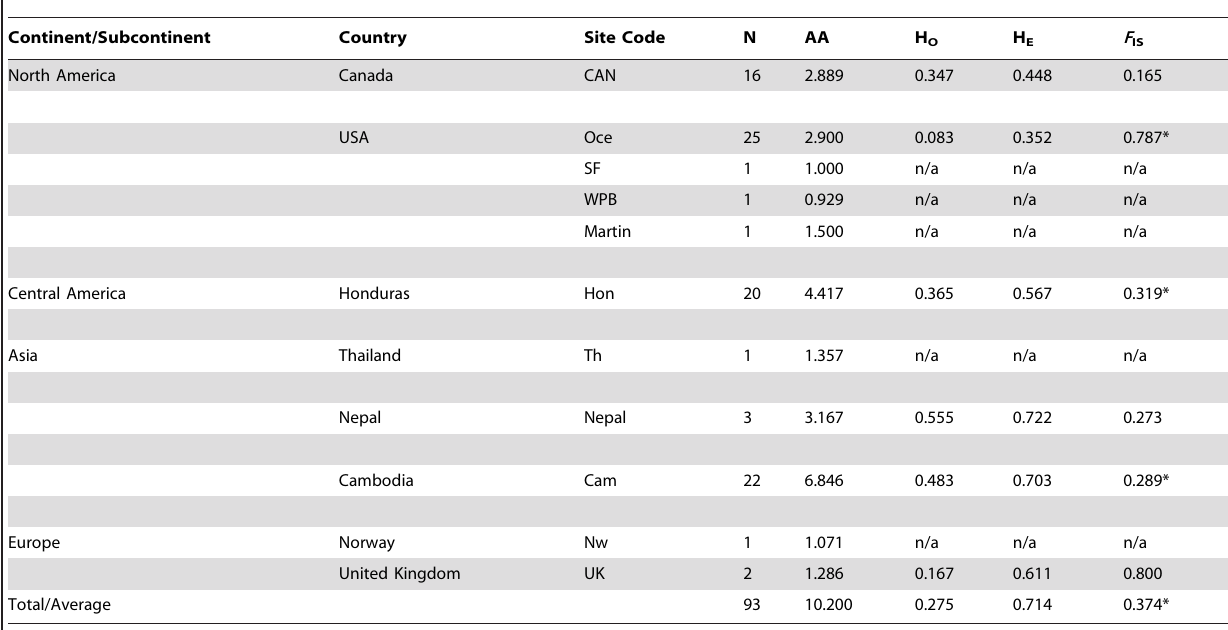
Table 2. Microsatellite polymorphisms among human louse populations.